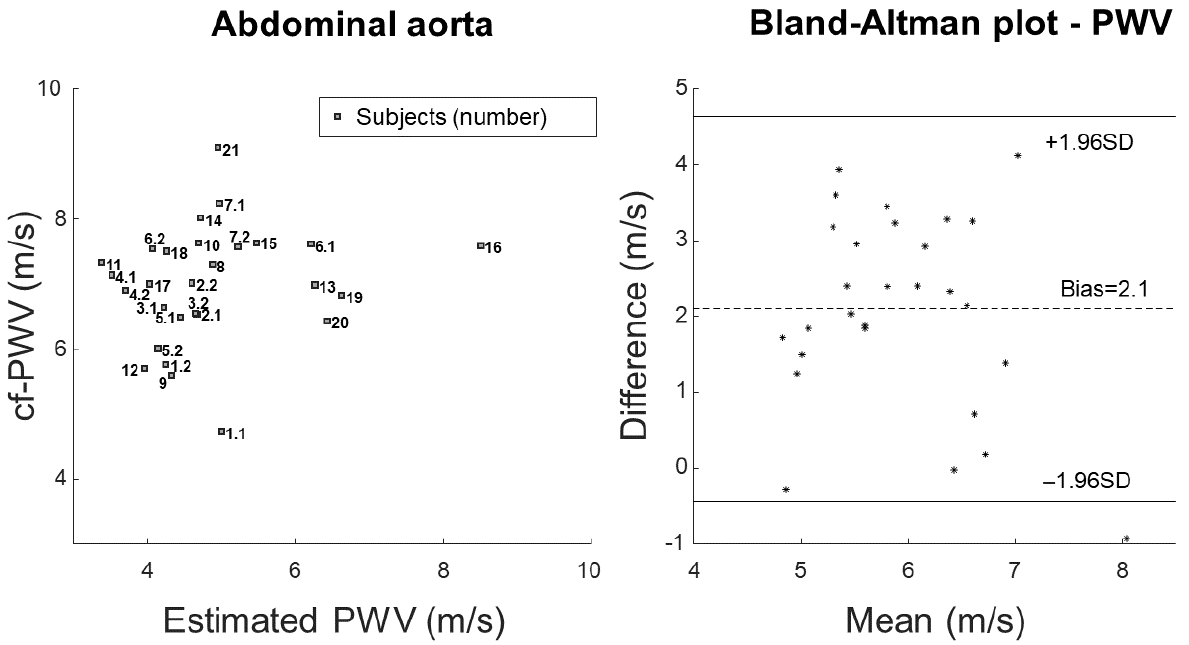
Figure 3. Comparison of PWV measured estimated by the Bramwell–Hill equation using the mea- surements of pulsatility and pressure variation (correlation coefficient 17.8%). Scatter plot ( left ) and Bland–Altman representation ( right ).